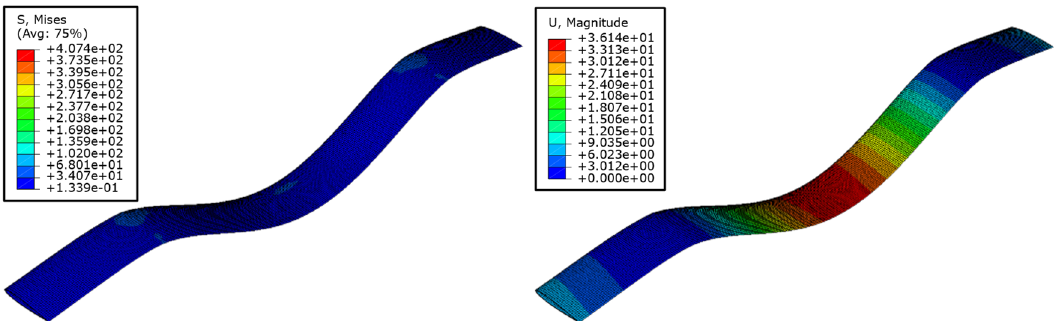
Figure 20. Von Mises stress S and displacements U with the optimal thickness of 5 mm of rotor blade 3 in V-Epoxy after applying extreme loads.